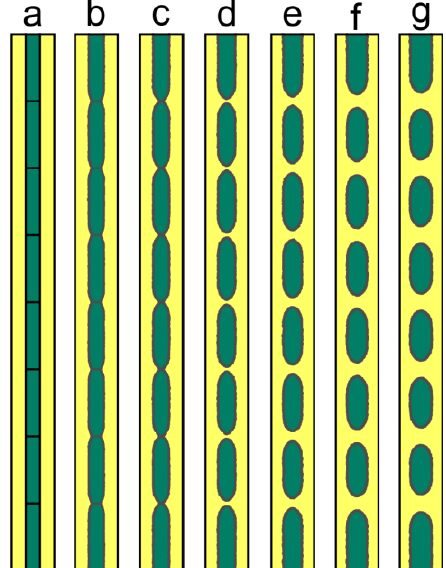
Figure 9. Microstructure evolution of a long cylinder with inner substructures. ( a ) t = 0 s; ( b ) t = 0.2 s; ( c ) t = 0.4 s; ( d ) t = 0.6 s; ( e ) t = 0.8 s; ( f ) t = 1 s; ( g ) t = 1.2 s. Simulation grid is 3000 × 240 with the cell size of 0.001 μm.